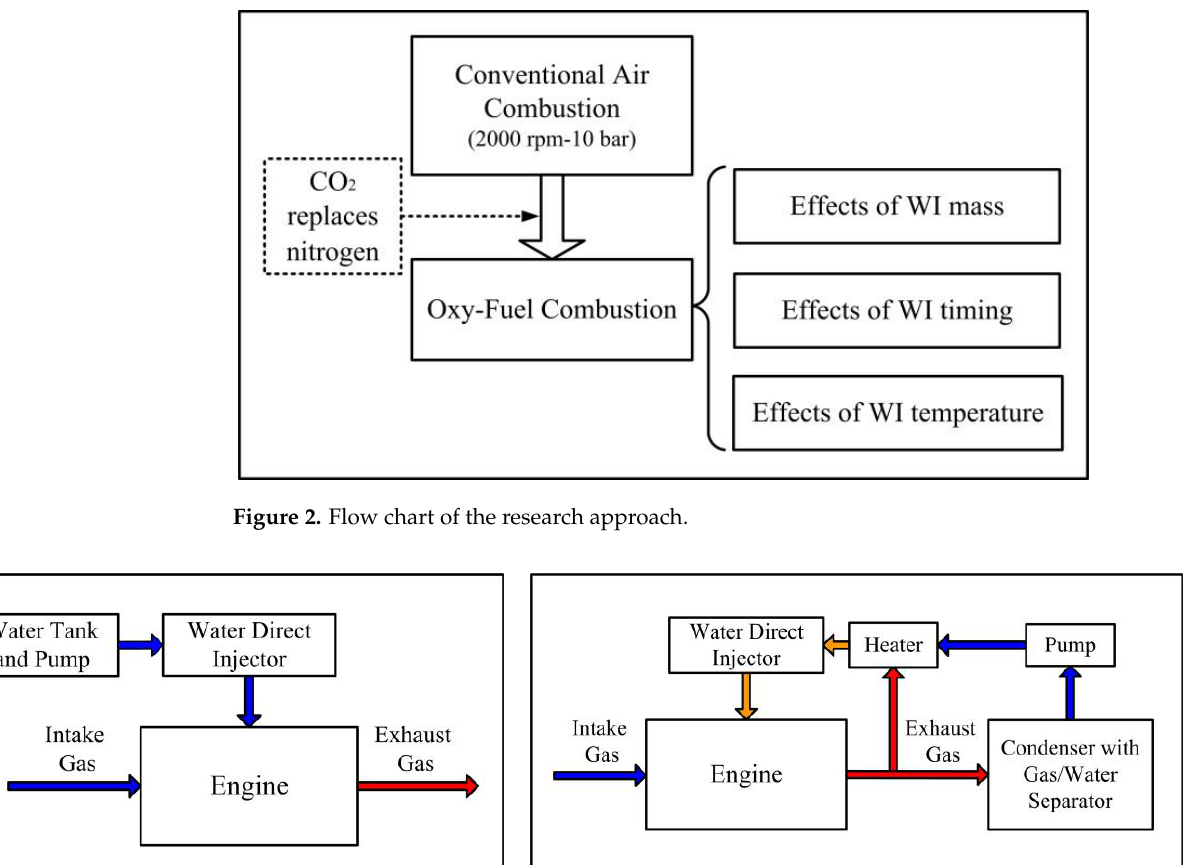
Figure 2. Flow chart of the research approach.